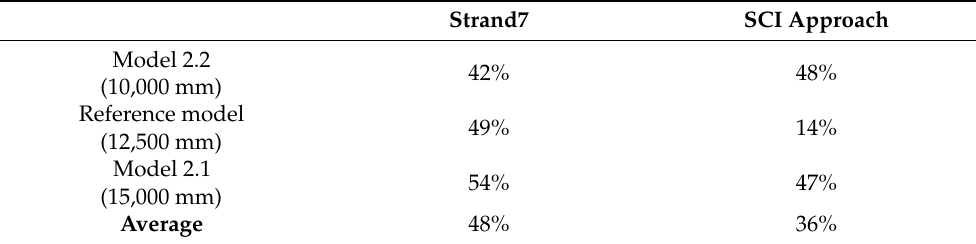
Table 15. Possible error between different approaches (change in primary beam length).